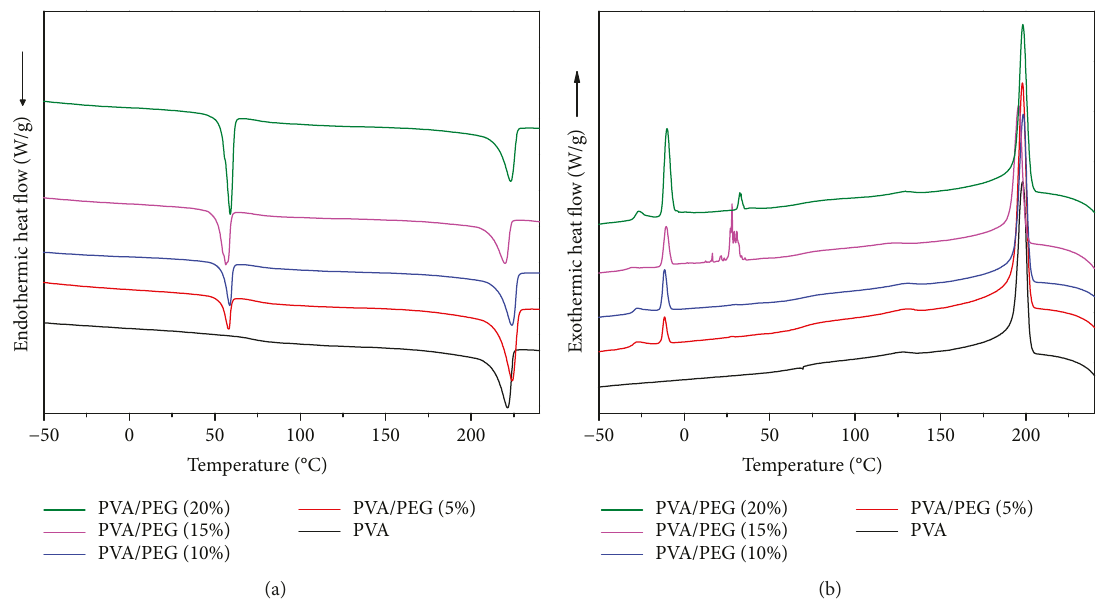
Figure 2: DSC thermograms for PVA and its blends at di ff erent PEG loadings: (a) heating curves and (b) cooling